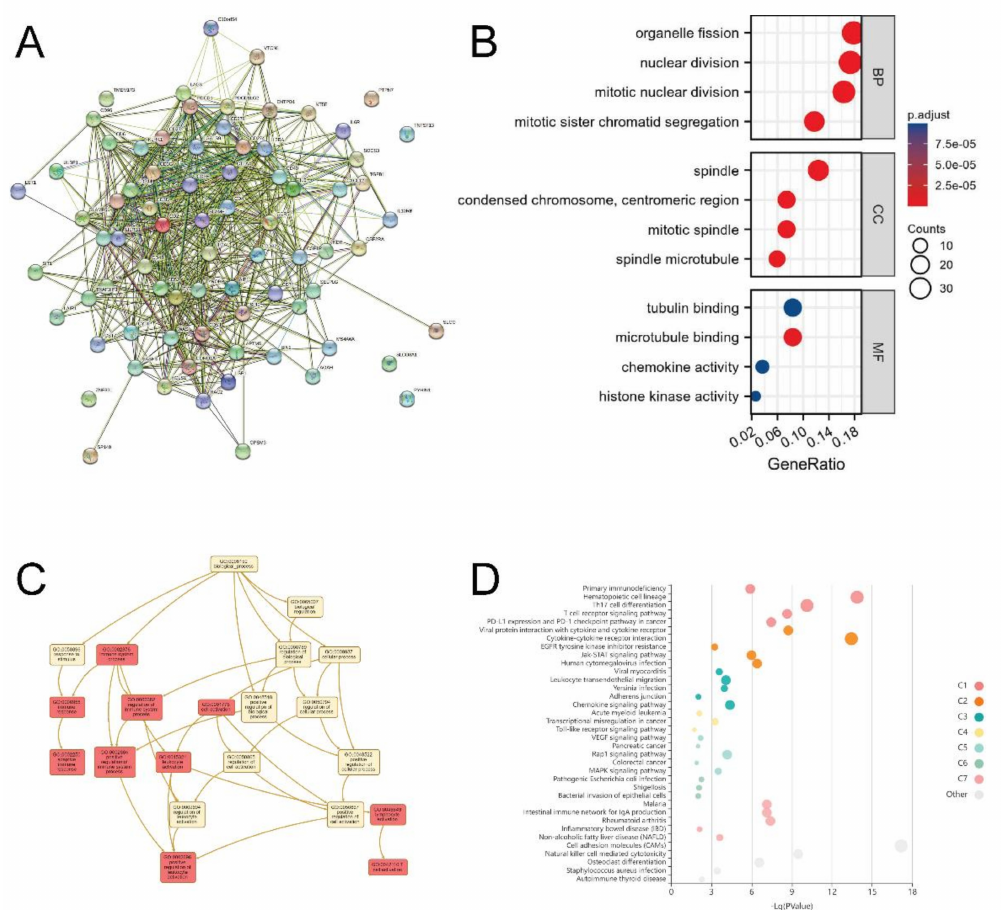
Figure 10. EZH2-associated GSEA: ( A ) PPI network of 13 EZH2-associated immuno-inhibitor genes, 14 EZH2-associated immuno-stimulator genes, and the top 50 co-expressed genes using STRING; ( B ) GO annotation of the abovementioned 77 genes; ( C ) Enriched GO terms network from We- bGestalt; ( D ) KEGG and Reactome pathway enrichment analyses of the abovementioned 77 genes using